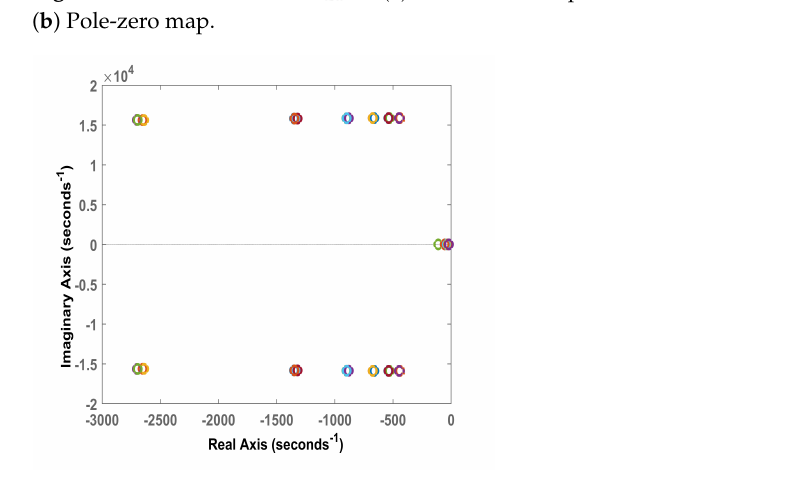
Figure 6. Pole and zero map of numerator Gi L 1 d _ u ( s ) at different output power.